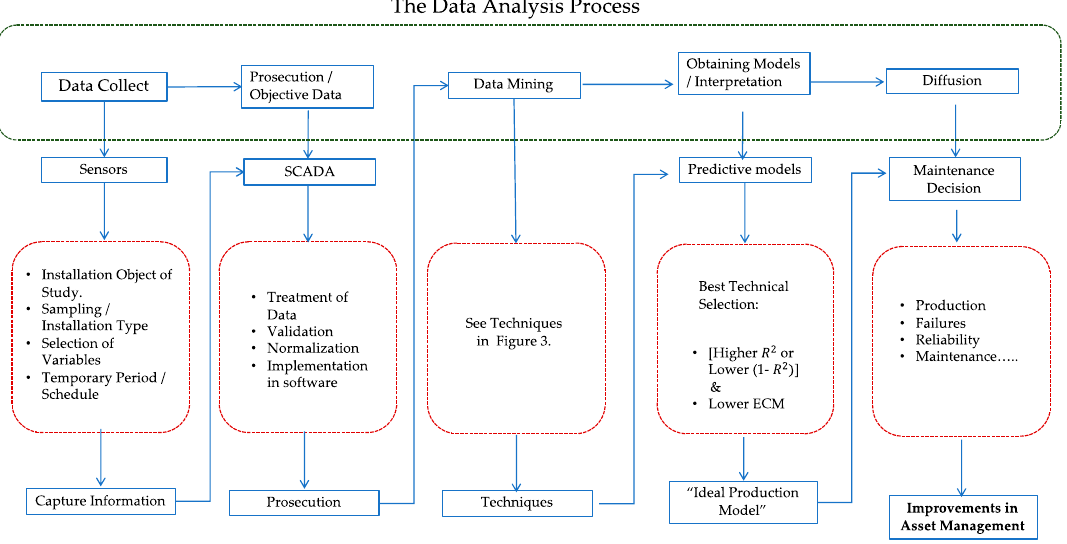
Figure 1. IDA phases for a renewable energy case study [9,10].